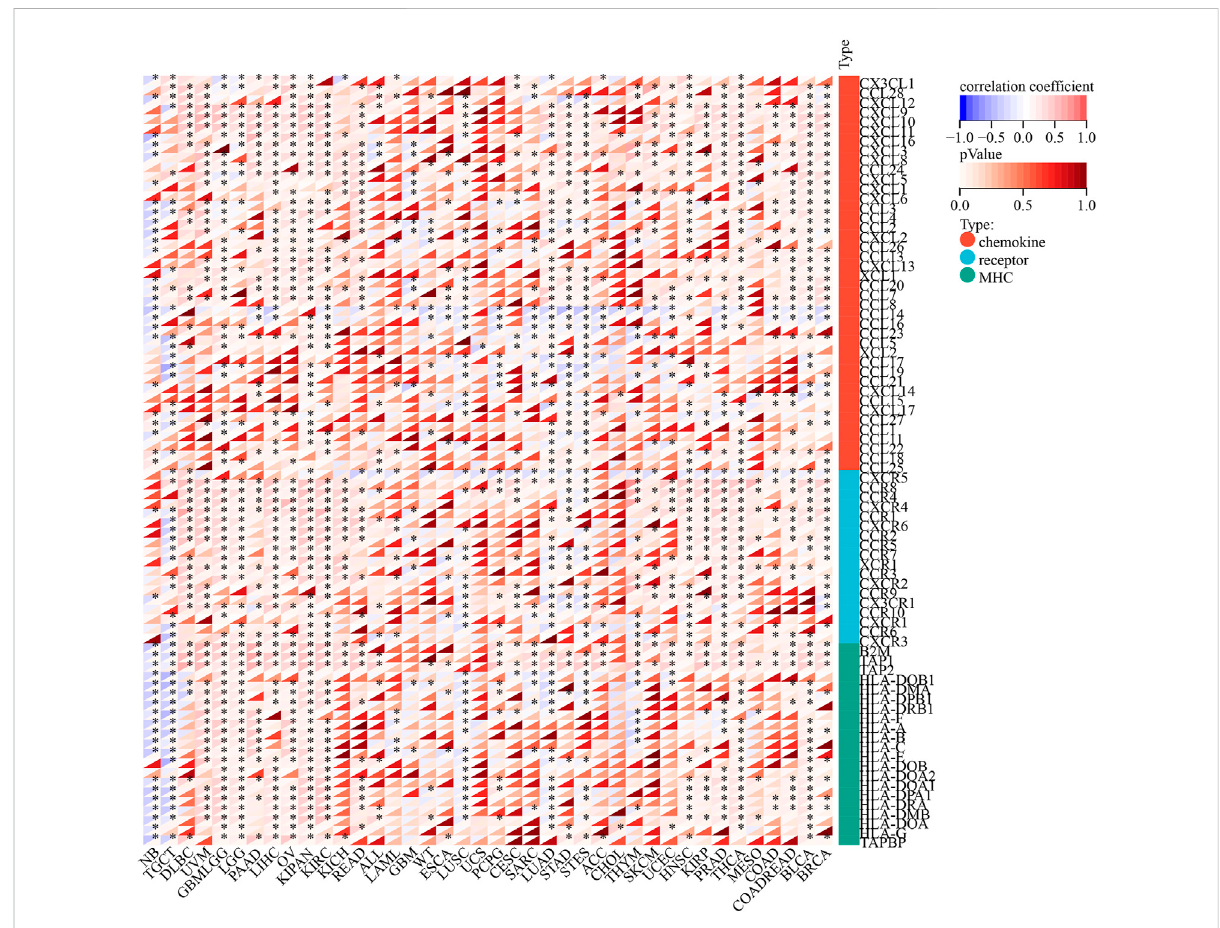
FIGURE 8 Relationship between RAD51AP1 and chemokine and its receptors genes in pan-cancer. The expression of RAD51AP1 was signi fi cantly correlated with CXC and CC family, chemokine receptors, and MHC class I and II in various cancers. MHC, major histocompatibility